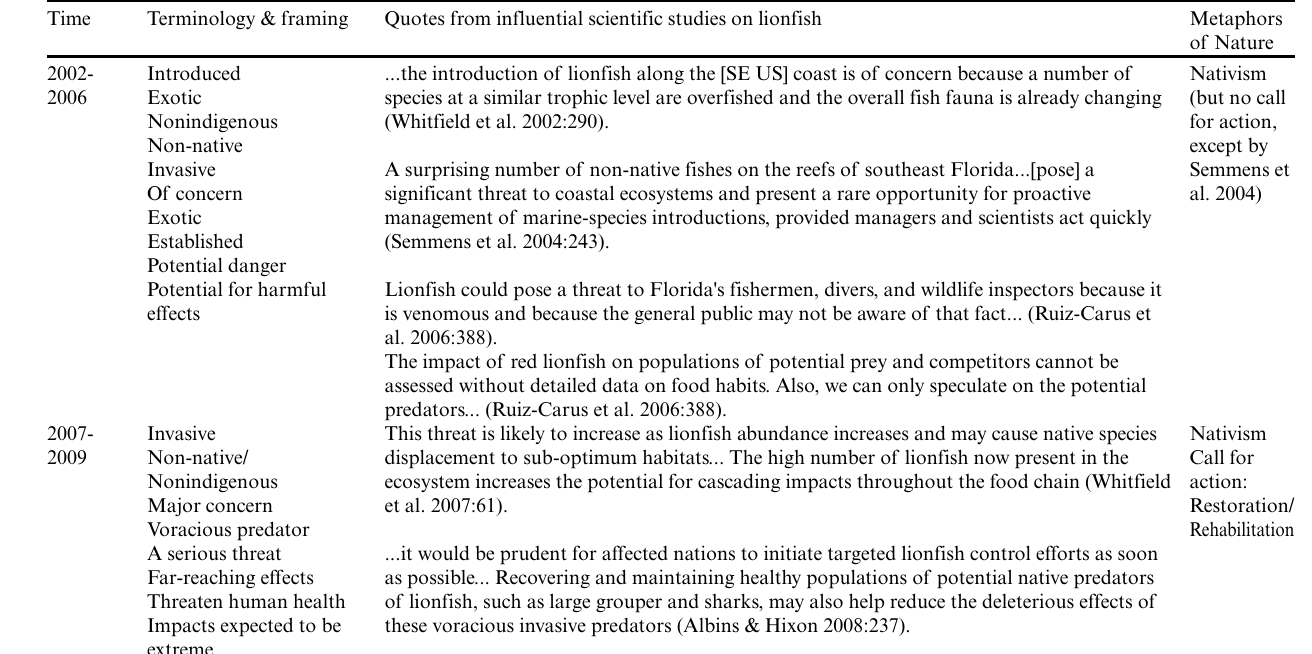
Table 2 . Scientific discourse formation on Western Atlantic lionfish ( Pterois sp.): from speculation to characterization as a threat and advocacy of lionfish removal and